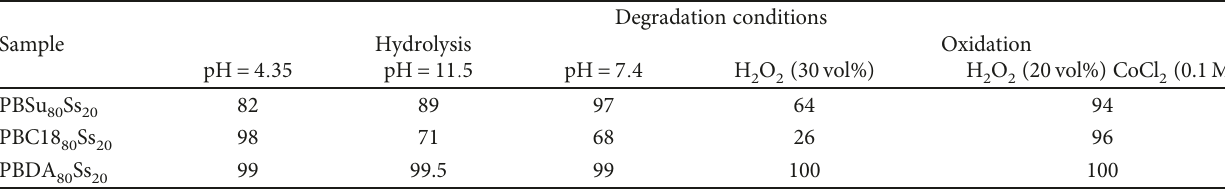
Table 4: Remaining weight (%) of PBSu (30 vol%) and